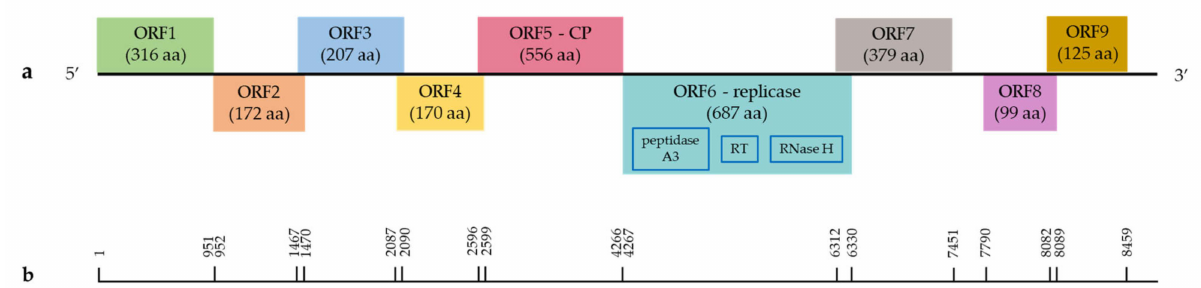
Figure 5. Linear representations of the dsDNA genome of grapevine pararetrovirus (GPRV). ( a ) Pre- dicted open reading frames encoding proteins with unknown function (ORF1-ORF4 and ORF7-ORF9), coat protein (CP, ORF5) and polymerase polyprotein P6 (ORF6) with domains of peptidase A3, reverse transcriptase (RT) and ribonuclease H (RNase H) are shown. ( b ) Nucleotide positions of GPRV